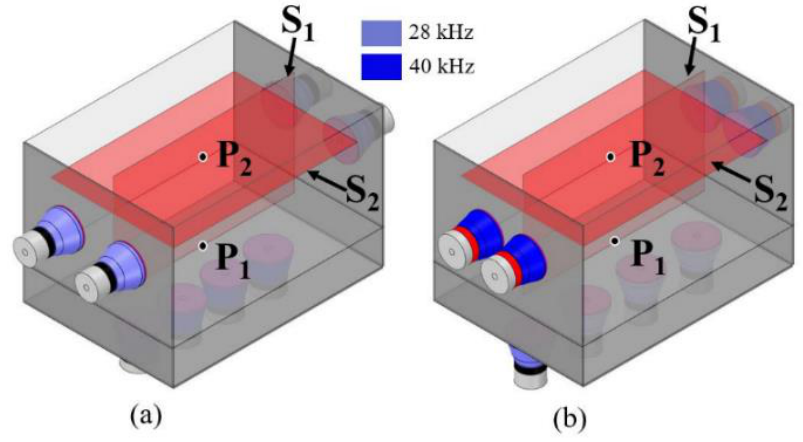
Figure 10. Most possible models for simulation: ( a ) model A and ( b ) model B.